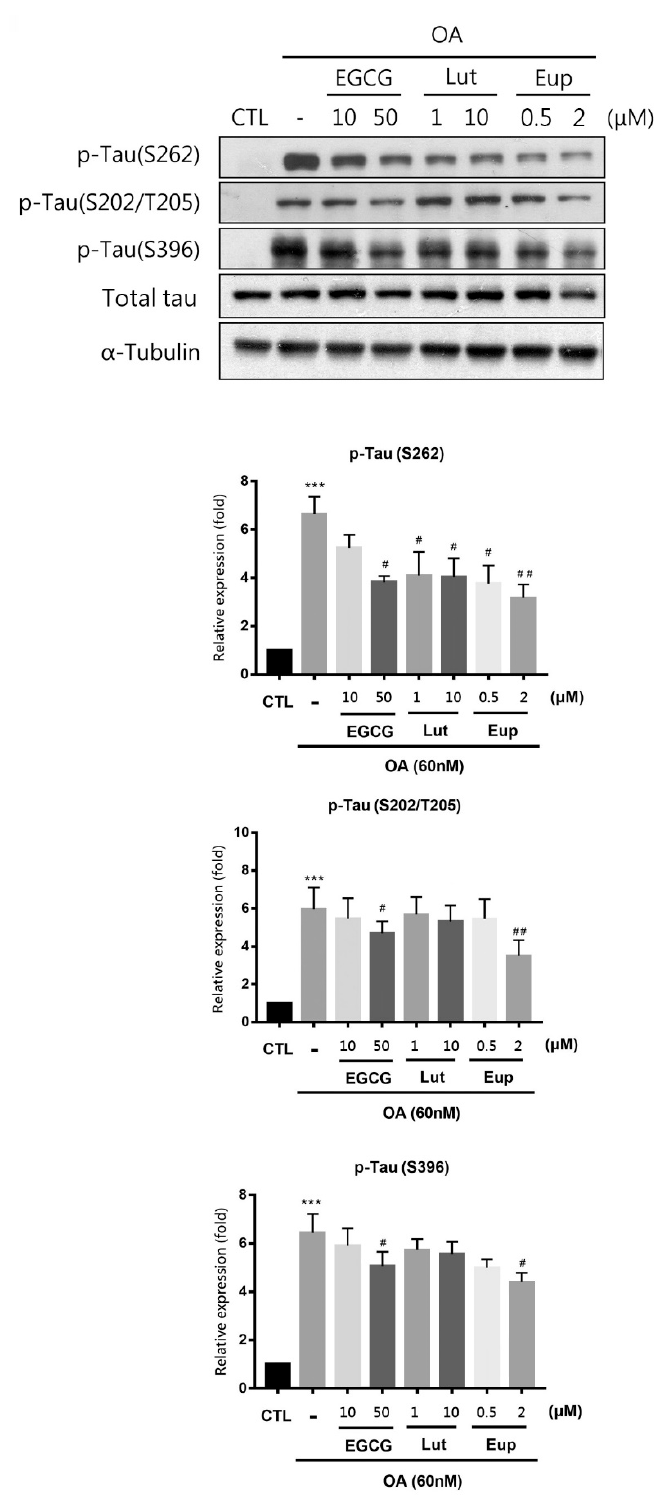
Figure 4. Eupatin significantly inhibited okadaic acid (OA)-induced tau phosphorylation. Neuro-2a cells were treated with indicated concentrations of EGCG, luteolin, or eupatin for 24 h before 6-h incubation with 60 nM OA. Western blotting of cell lysates was performed using the specified antibodies. The results are presented as the mean ± standard error of the mean of three independent experiments. *** p < 0.001 for comparisons with the control group; # p < 0.05 and ## p < 0.01 compared with the OA-treated group.